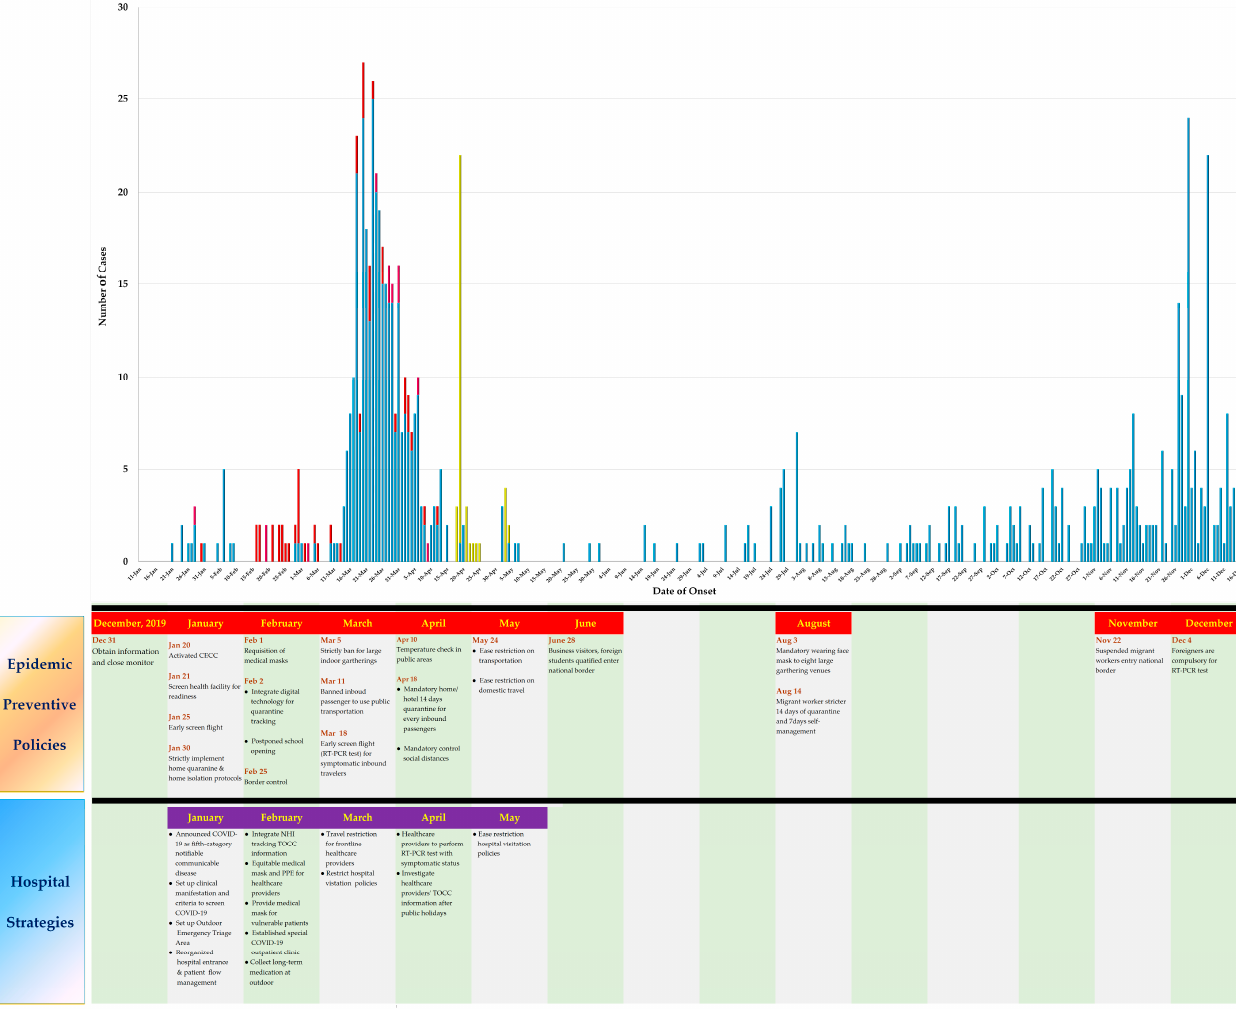
Figure 2. COVID-19 daily confirmed cases reported in Taiwan.